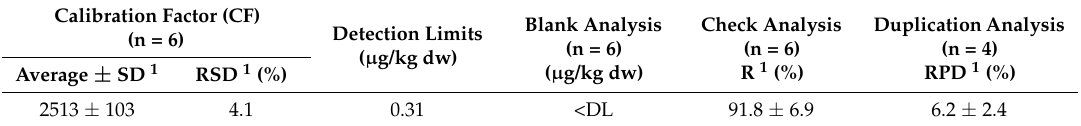
Table 1. Calibration factor, detection limits, recoveries of check standards, and relative percent differences of sample duplicates for MeHg analysis.